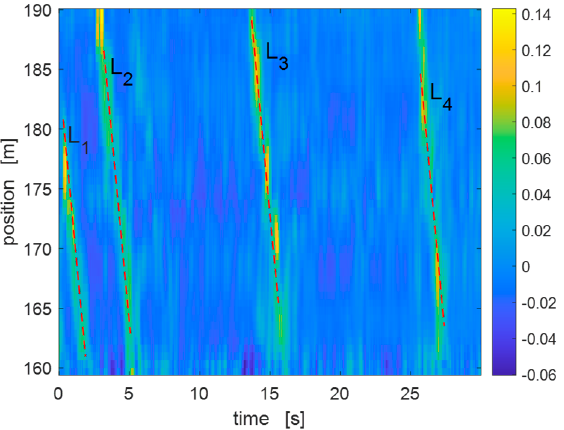
Figure 16. Distributed acoustic sensor recordings superimposed on the lines detected by the Hough transform (from Ref. [144]).